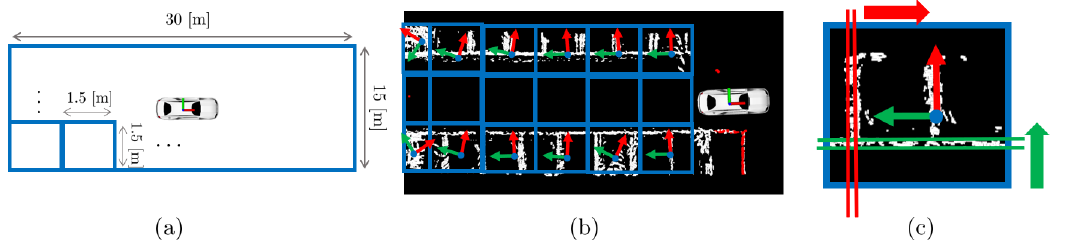
Figure 5. The data registered in the map is cut into areas of 1.5 × 1.5 m (blue box), and the principal component analysis (PCA) is applied to each area. ( a ) The dimension of division areas. ( b ) The PCA is used for obtaining the major axis of the data for each area (red and green arrows). ( c ) Determination of data distribution in the direction along the major axis for analyzing the data